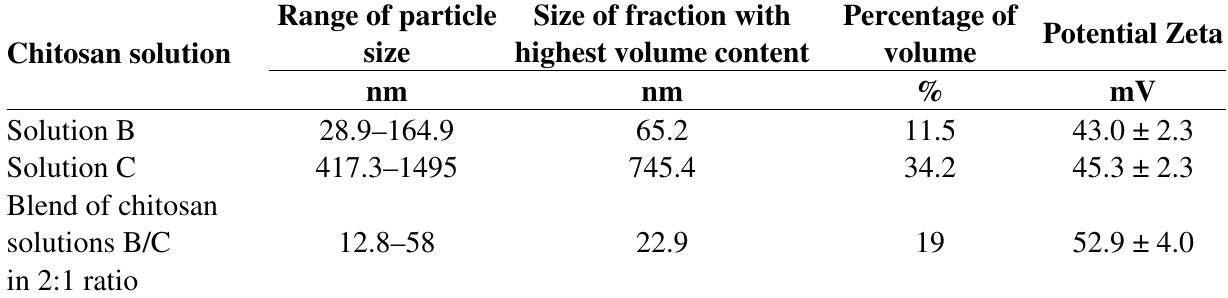
Table 2. Selected parameters of chitosan solutions containing HAp, β -TCP and HAp/ β